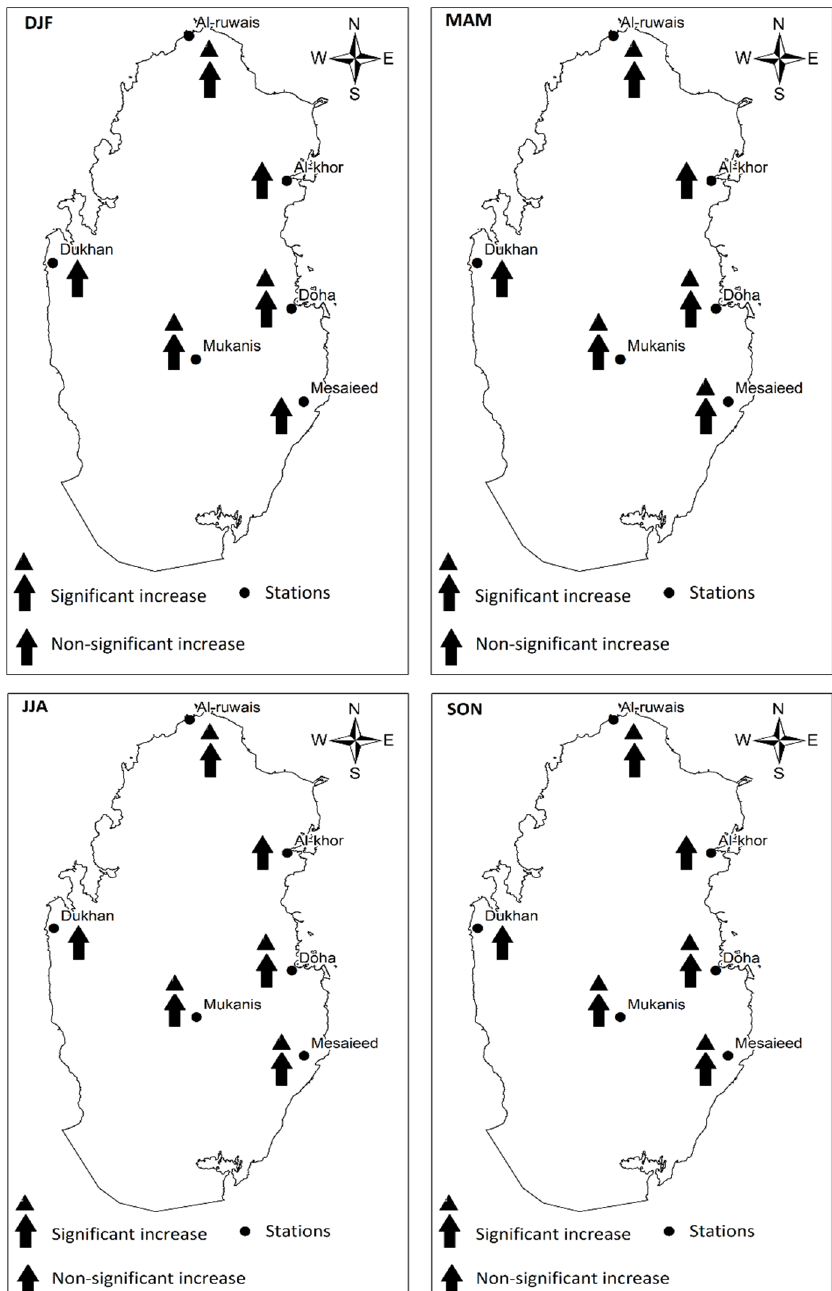
Figure 7. Station wise seasonal monthly mean temperature trends. DJF = December, January February; MAM = March, April, May; JJA = June July August; SON = September, October, November). Data source QMD.